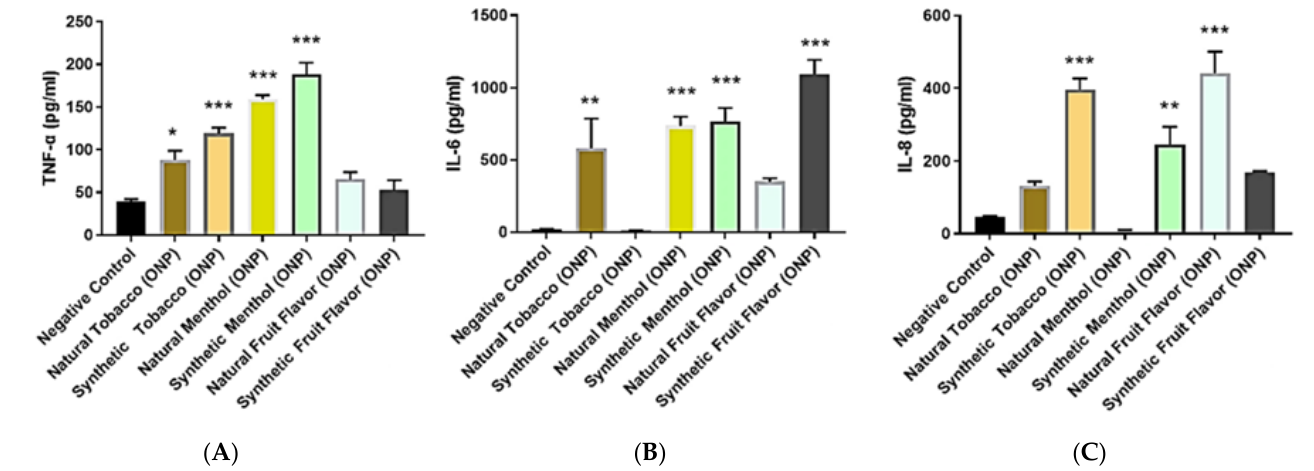
Figure 7. Inflammatory mediator response by oral nicotine products in oral epithelial cells: HGEPp cells were treated at oral nicotine pouches extracts categorized with natural/synthetic tobacco, menthol, and fruit flavors) of different brands (Snus, Zyn, Grizzly, Lucy, and ON). Following 24 h exposure, conditioned media was used to perform ELISAs. ( A ) Protein levels of TNF- α deter- mined by ELISA. ( B ) Protein levels of IL-6 determined by ELISA. ( C ) Protein levels of IL-8 determined by ELISA. Data represented as mean ± SEM, * p < 0.05, ** p < 0.01, *** p < 0.001 compared to negative control (untreated) n = 3.